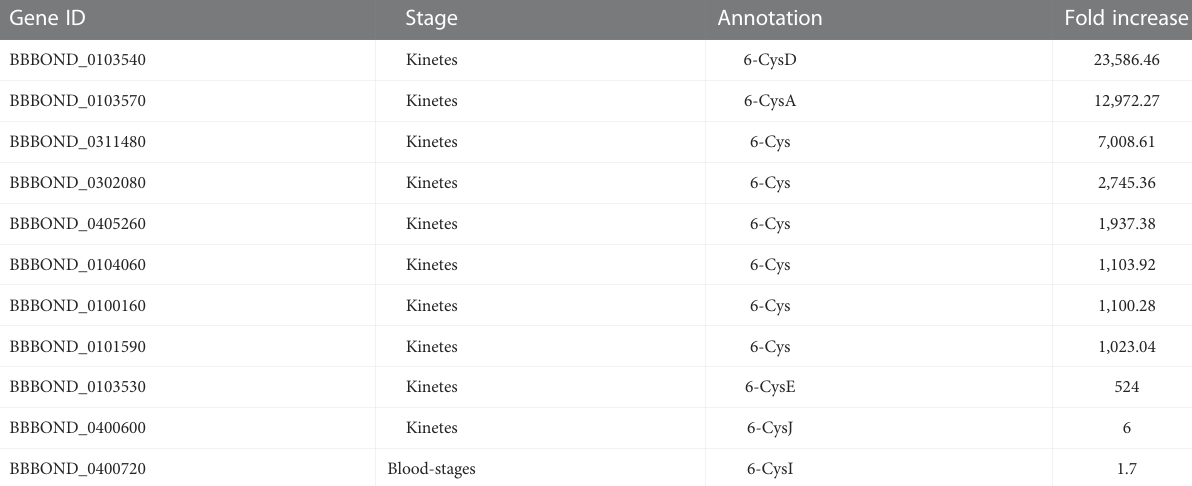
TABLE 6 Upregulated 6-Cys gene family in B. bigemina kinetes and blood-stages. Gene ID